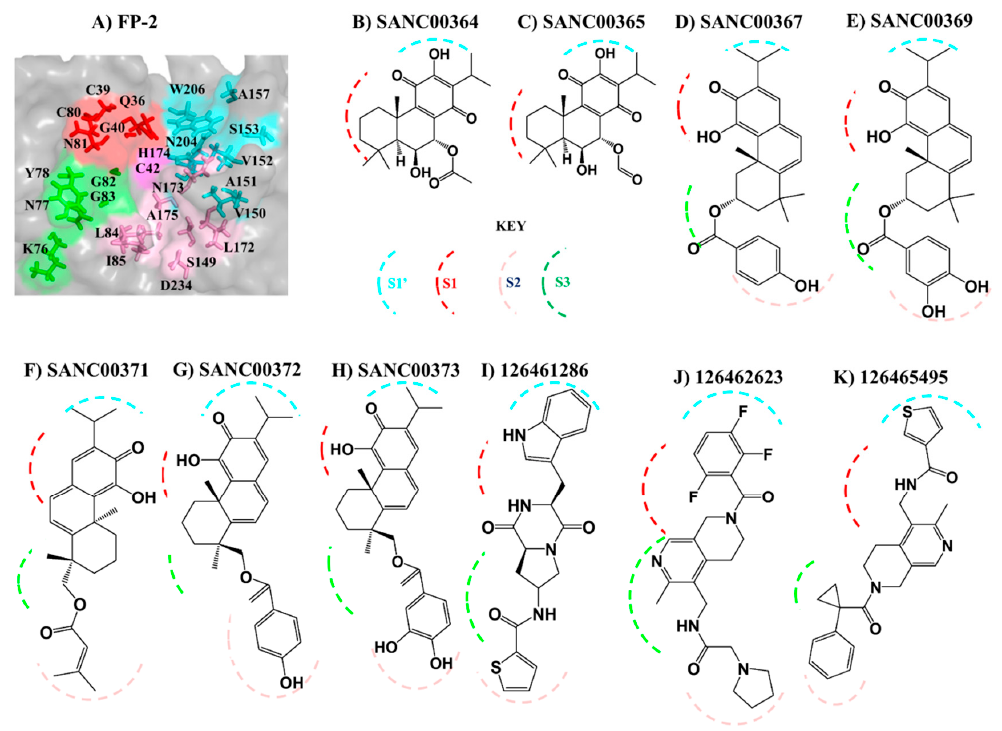
Figure 5. Ligand binding mode in plasmodial proteases. ( A ) A zoomed surface representation of the FP-2 active site. Shown in sticks are the different subsite residues (S1 = Q36, C39, G40, C80, N81; S2 = L84, I85, S149, L172, N173, A175, D234; S3 K76, N77, Y78, G82, G83; S1 ′ = V150, A151, A157, H174, N204, W206). ( B – K ) Schematic representation of the interactions of the different compounds with the four subsites in the plasmodial proteins. S1 = Red, S2 = Pink, S3 = Green and S1 ′ = Pink broken lines.